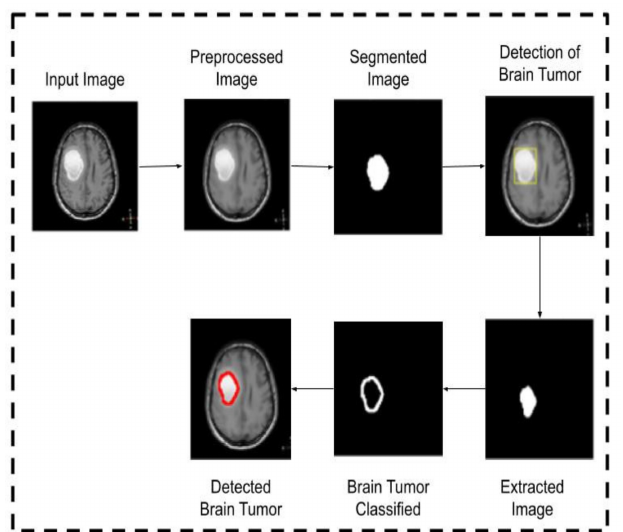
Figure 2. Operation of input image1.